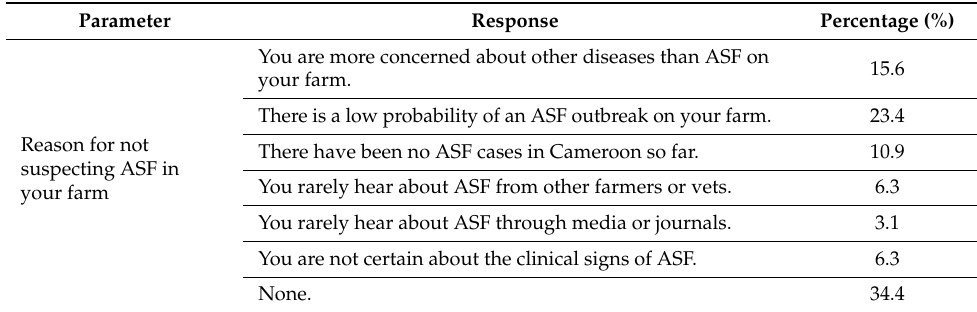
Table 8. Major reasons for not suspecting ASF in a